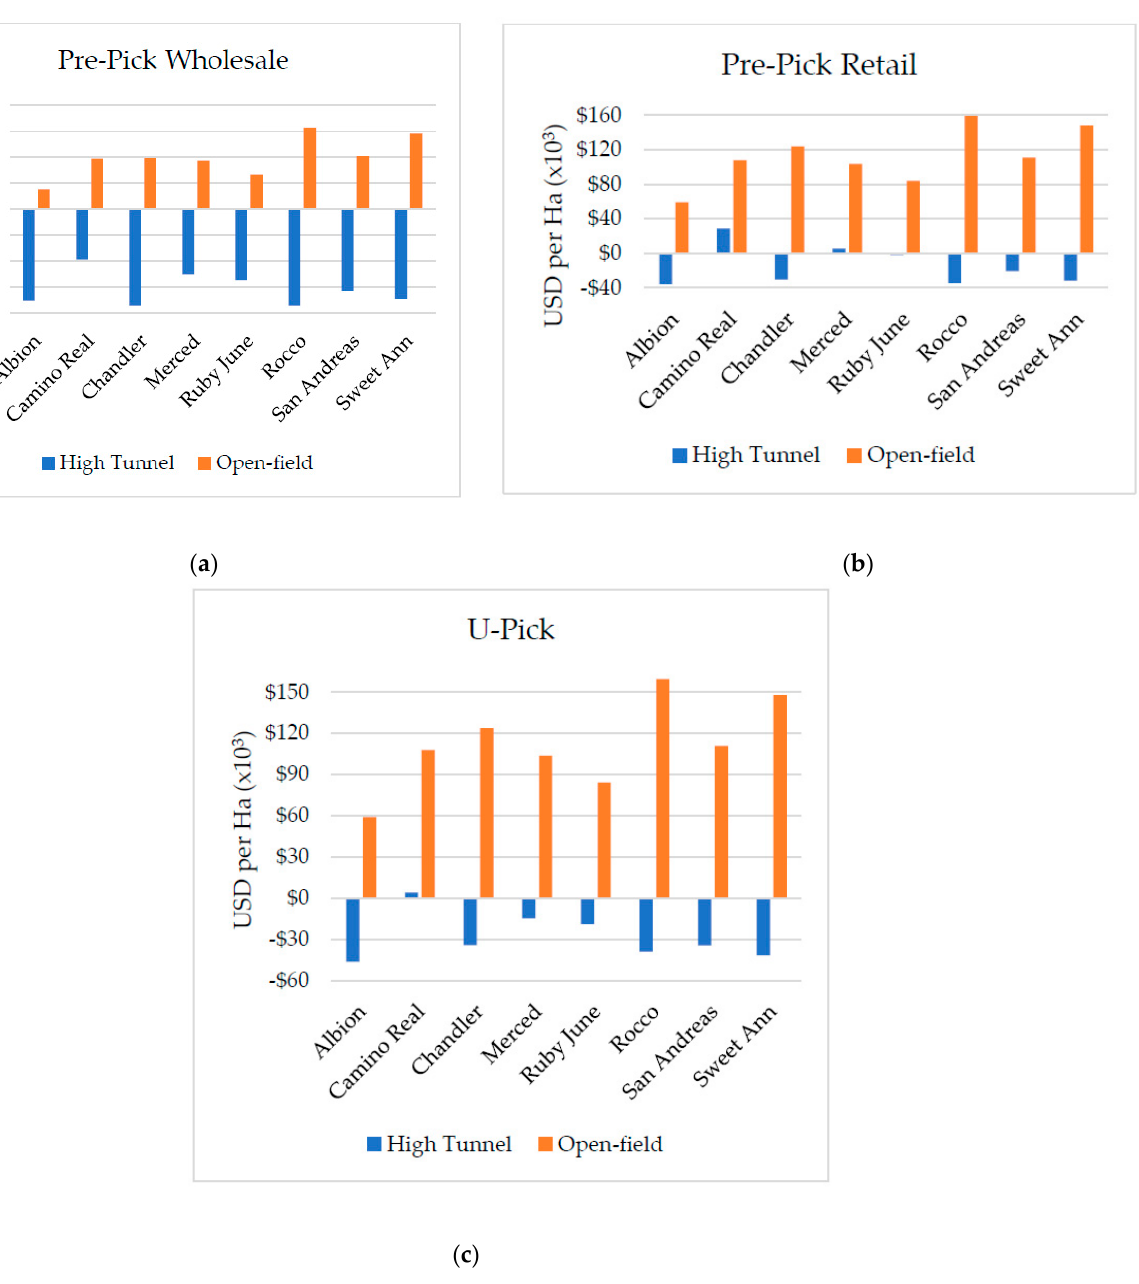
Figure 5. Net revenues in USD per hectare from strawberries produced under a high tunnel and in the open-field and marketed at a ( a ) pre-pick wholesale, ( b ) pre-pick retail, and ( c ) U-pick